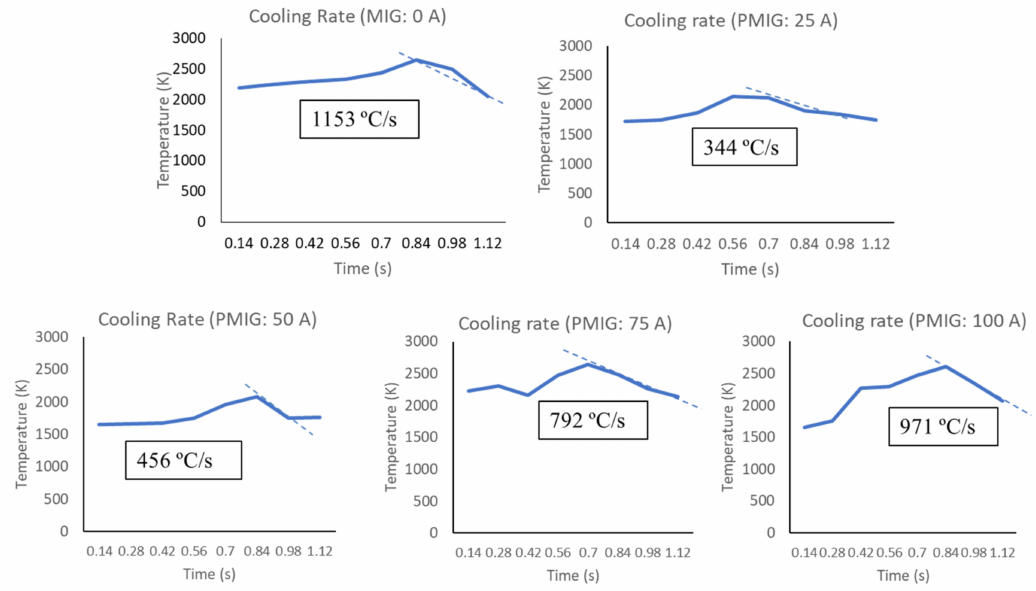
Figure 4. Cooling rate graph for different plasma